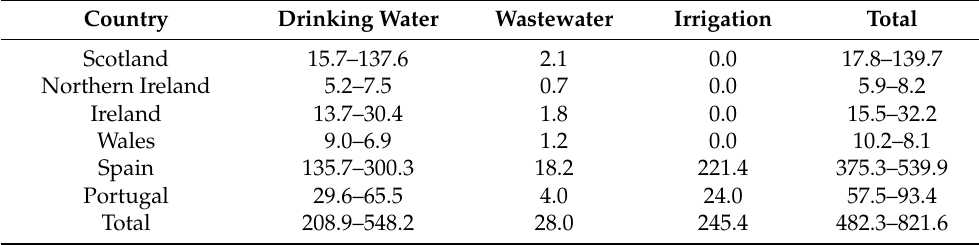
Table 8. Summary of total annual MHP energy potential estimates (GWh) across the six countries and three sectors.